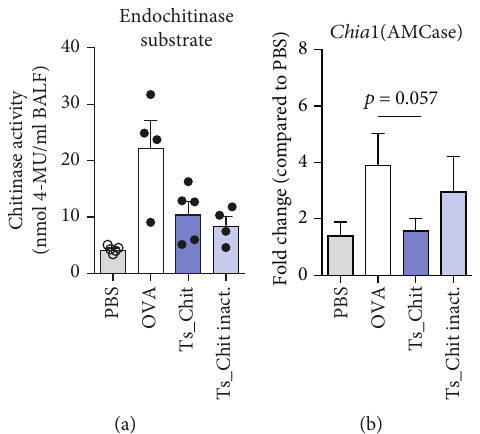
Figure 6: Ts -Chit treatment interferes with murine chitinase activity. (a) Chitinase assay testing BAL samples of allergic mice with endochitinase substrate. Data shown are mean + SEM of n = 4 – 5 replicates. (b) mRNA expression of murine chitinase AMCase ( Chia1 ) in lung tissue samples of mice from AHR challenge experiments after lung lavage. Expression was normalized by using the housekeeper gene peptidyl prolyl isomerase A ( PPIA ) and is presented as fold di ff erence to the PBS group. Data are presented as mean + SEM of n = 12 animals from n = 3 separate experiments. Data were analyzed statistically using an unpaired t